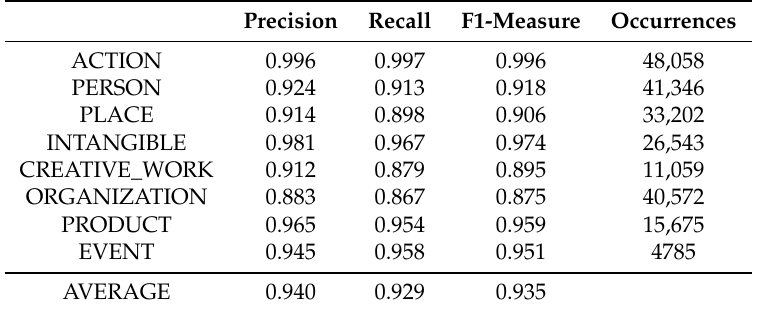
Table 1. The results obtained from the execution of CRF model using the standard configuration. Precision